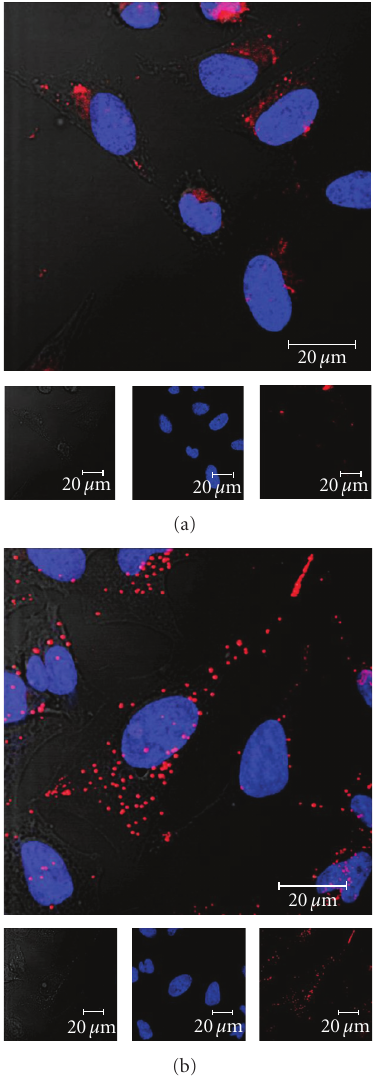
Figure 5: Confocal microscopic images of fixed HeLa cells incu- bated with polymeric carrier for PSs (b) or free PSs (a) for 6 h [13]. Maeda et al. termed the enhanced permeability and retention (EPR) e ff ect